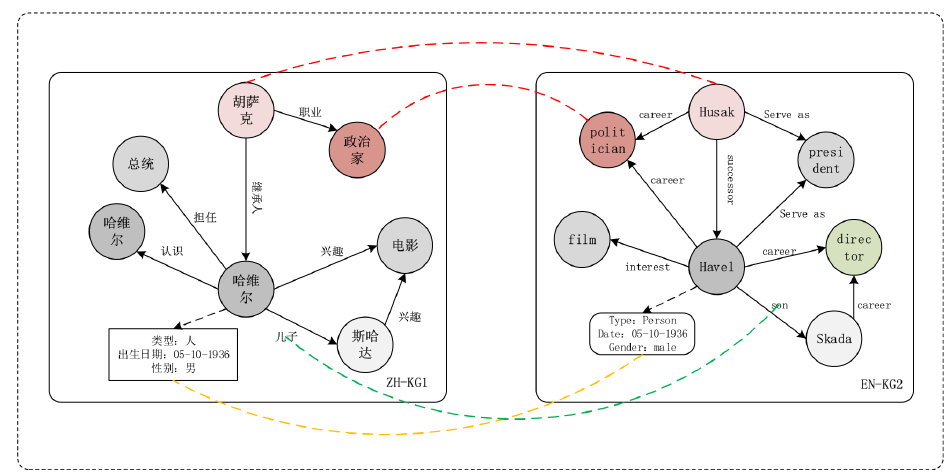
Figure 1. Chinese and English knowledge graph